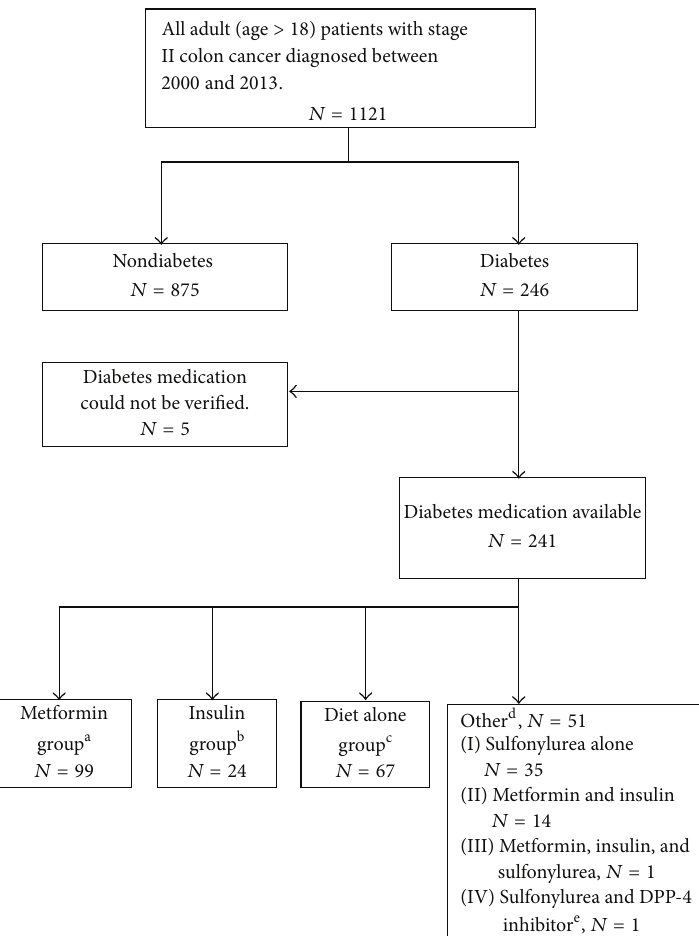
Figure 1: Flow chart—study population. a Metformin with or without sulfonylurea; b insulin with or without sulfonylurea; c no diabetes medication; d sulfonylurea alone or other combinations; e dipeptidyl peptidase-4 inhibitor, sitagliptin used in this one